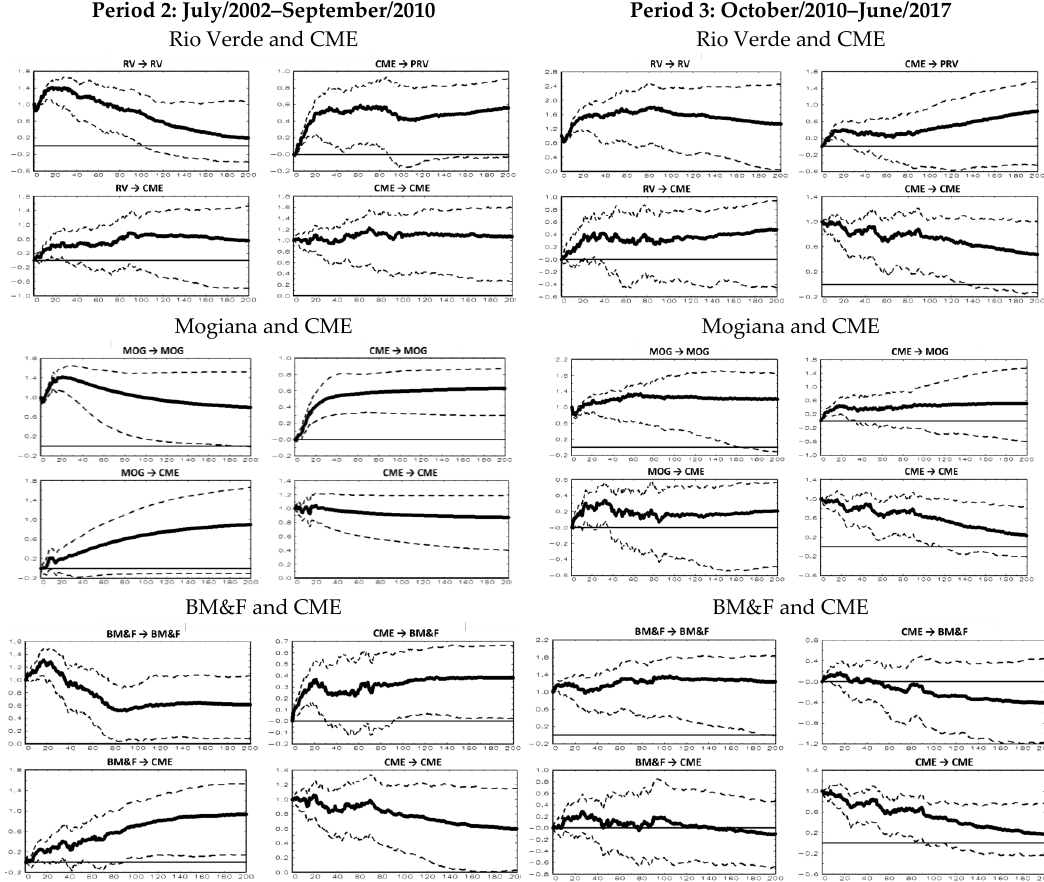
Figure A3. Impulse-response analysis for spot prices in Brazil and futures prices in the U.S., and futures prices in Brazil and U.S. in 2002–2010 and 2010–2017. Note: the 95% bootstrapped confidence intervals are based on Benkwitz et al. (2001).